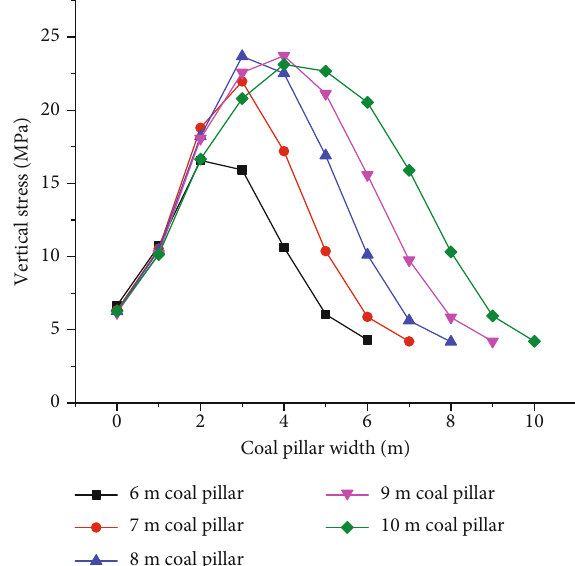
Figure 7: Vertical stress distribution law of coal pillars with di ff erent widths when the workface was advanced